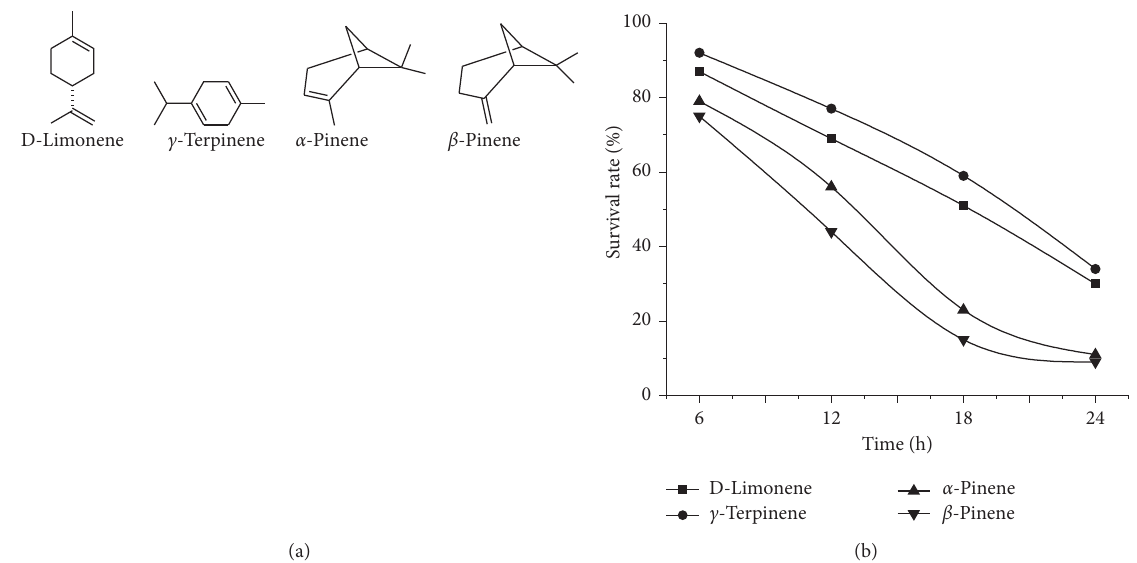
Figure 6: (a) Structural formulae of four components. (b) Effects of four components from the essential oil of flesh fingered citron on the mortality of C. elegans